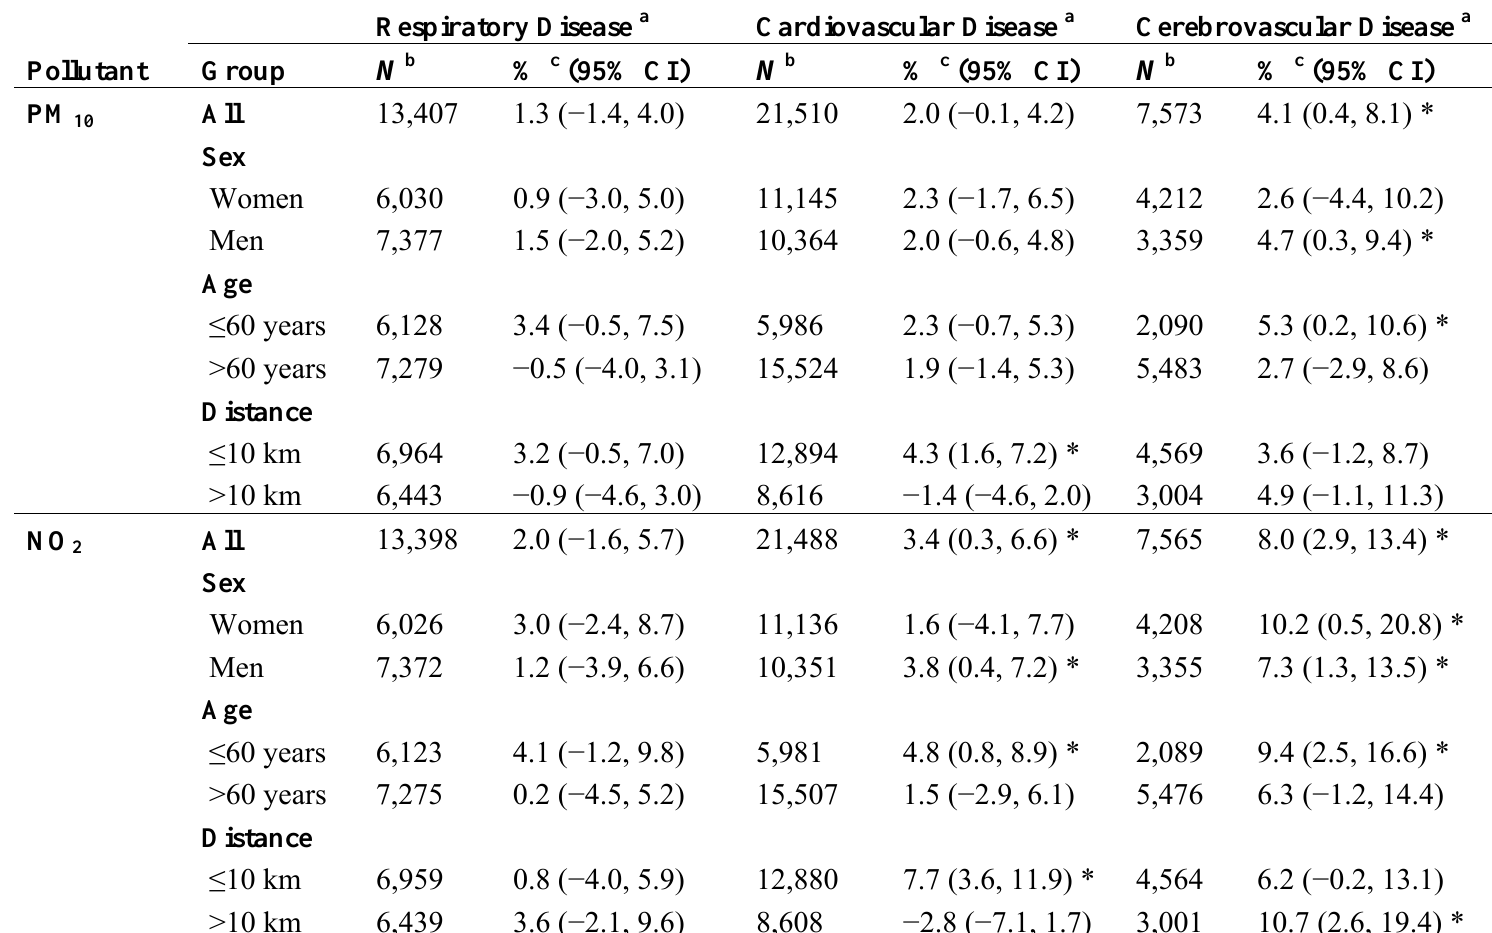
Table 2. Association between air pollutant and cause-specific mortality in Cape Town, South Africa (entire year,